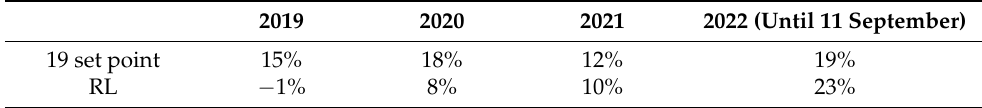
Table 4. Average cost savings from the baseline (21 ◦ C) per simulation